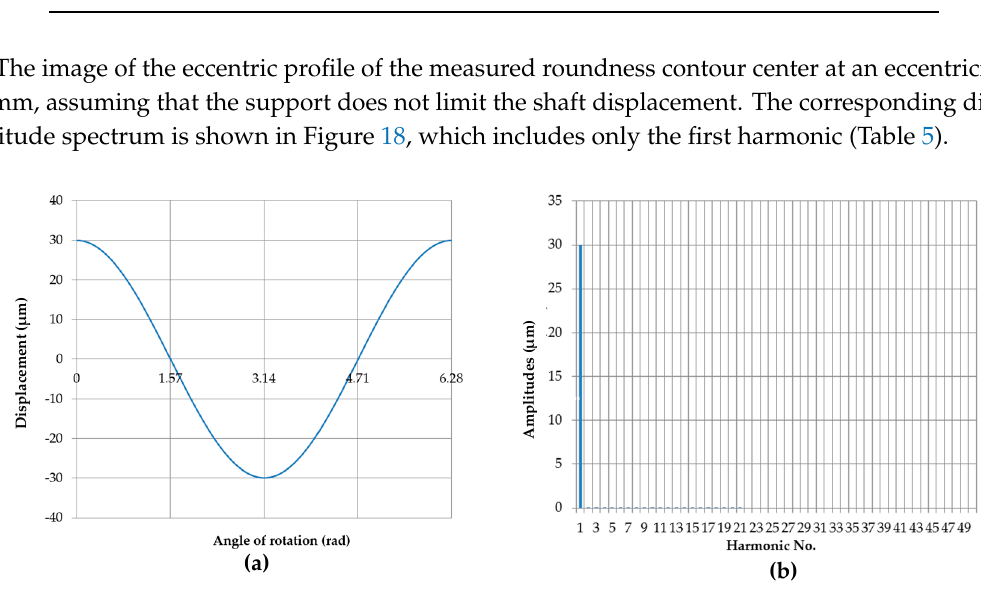
Figure 18. Eccentric movement profile of the center of the roundness profile being measured. The eccentricity was 0.03 mm, and the support did not limit the shaft displacement ( a ); discrete amplitude spectrum ( b ). Table 5. Amplitudes of the harmonic components for the eccentric movement of the center of the roundness profile being measured for eccentricity e = 0.03 mm where the support does not limit the shaft